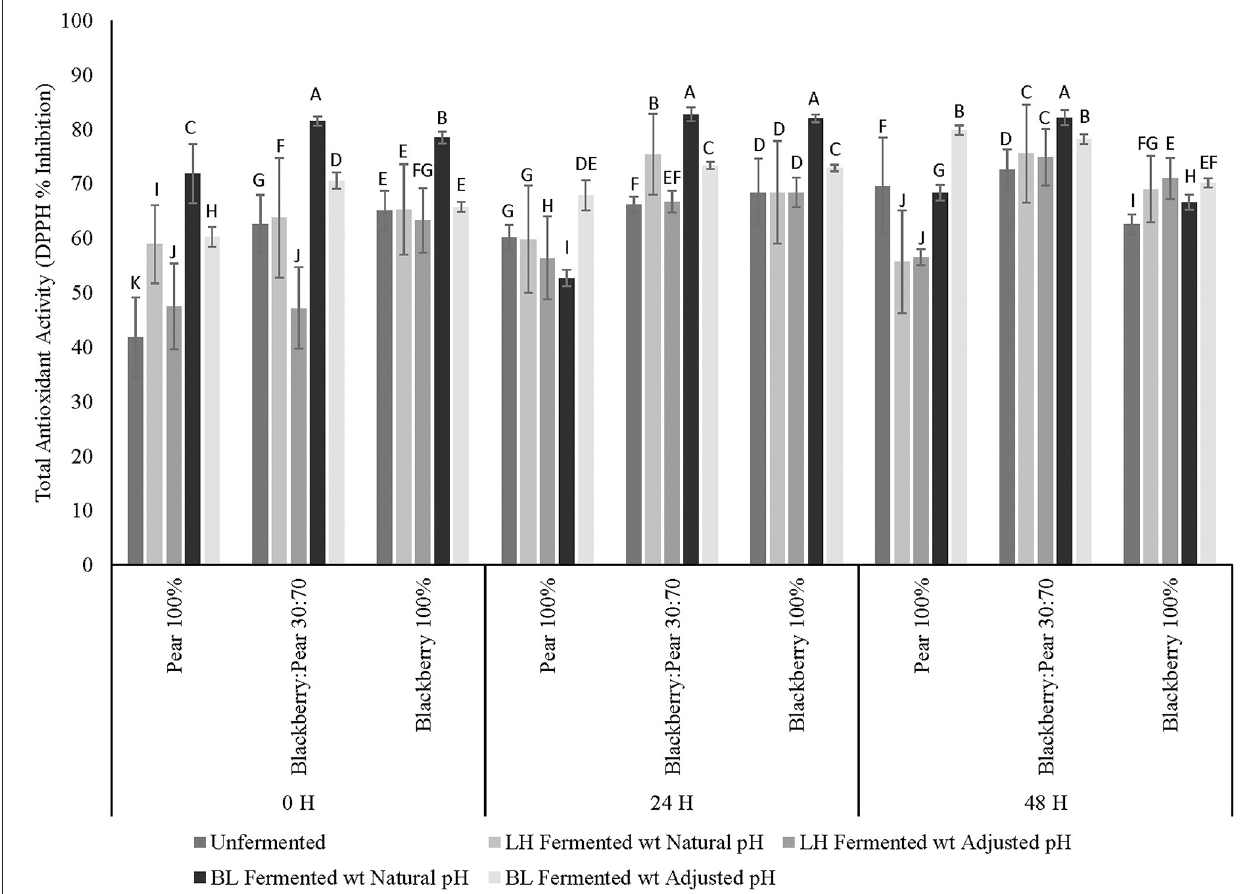
FIGURE 2 | Total antioxidant activity (DPPH-based inhibition) of Bartlett pear (100%), blackberry: pear (30:70), and Kiowa blackberry (100%) after fermenting with Lactobacillus helveticus (LH) and Bifidobacterium longum (BL) at 0, 24, and 48h time points. Different uppercase letters represent statistically significant ( p ≤ 0.05) differences in antioxidant activity between fruit sample extracts × fermentation treatment interactions separately at all 3 fermentation time